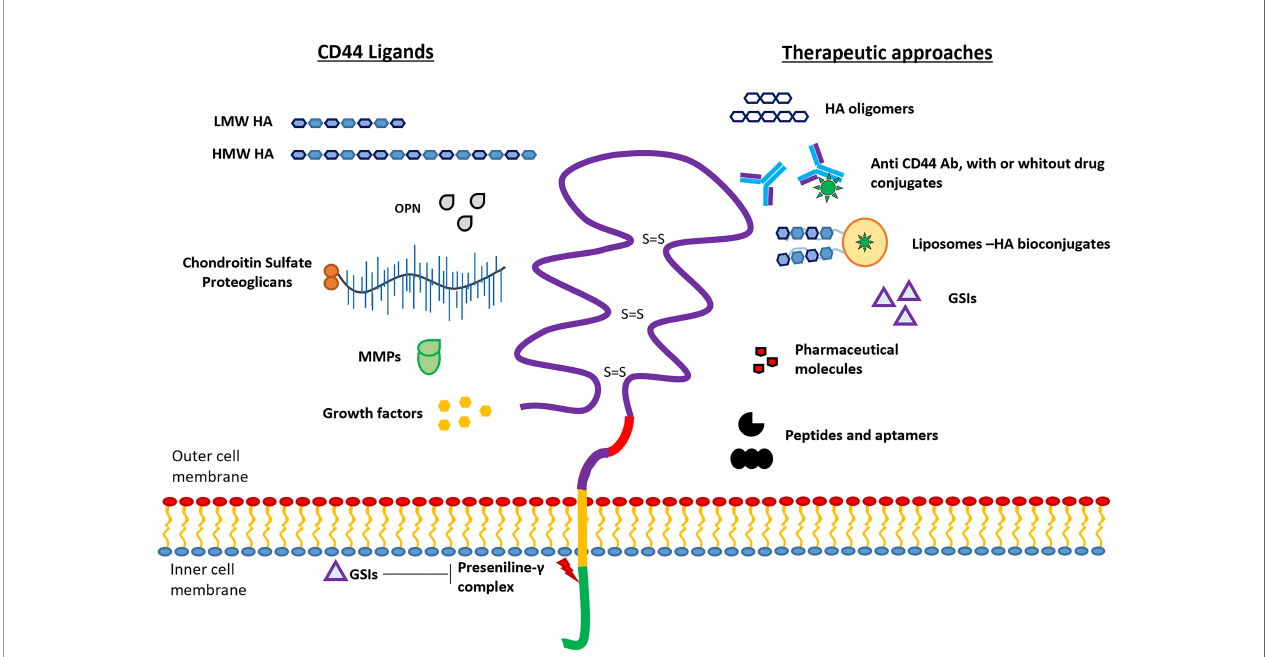
FIGURE 2 | Schematic representation of CD44 protein structure. The four domains of CD44 glycoprotein are represented with different colors: ectodomain (purple), variable domain (red), transmembrane domain (yellow), and intracellular domain (green). Ligands interacting with the ectodomain (left), and the different therapeutic approaches (right) are schematically represented. Presenilin ‐ g complex promotes the ICD cleavage which can be blocked by using g -secretase inhibitors